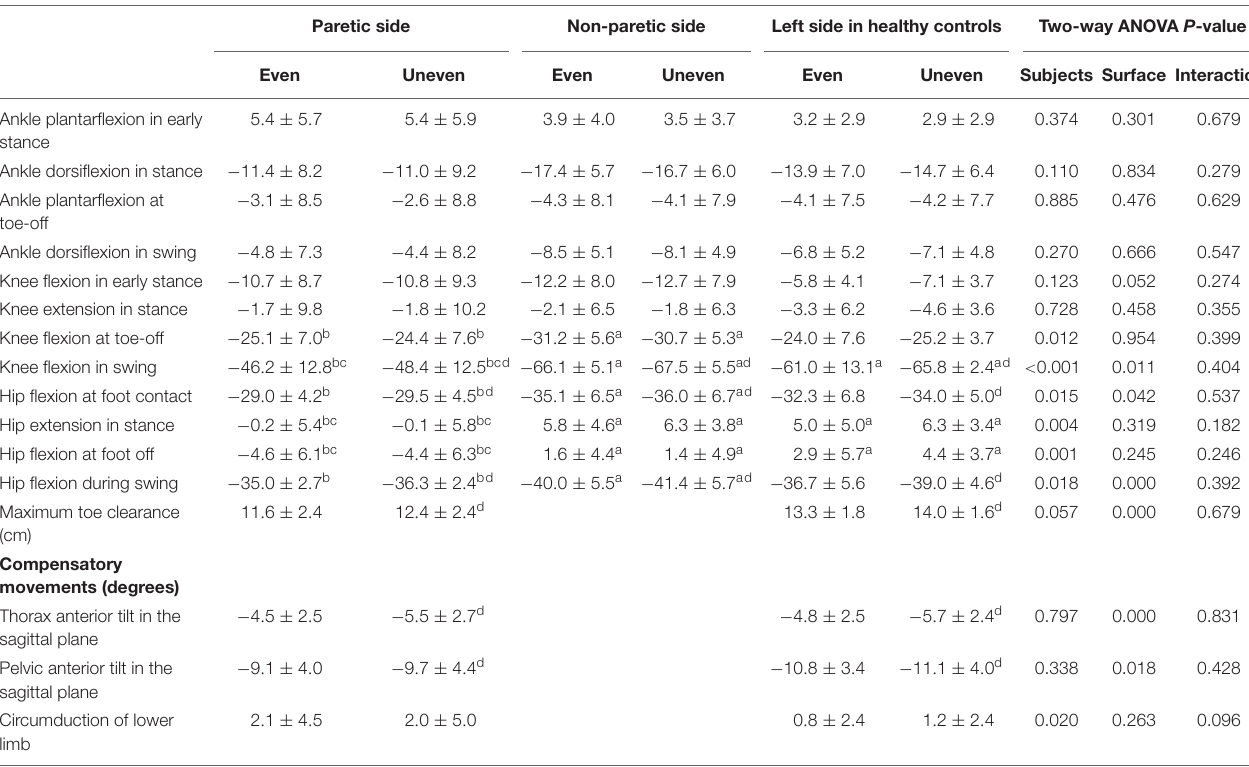
TABLE 4 | The mean and standard deviation of angles in lower limb in patients after stroke and healthy controls. Paretic side Non-paretic side Left side in healthy controls Two-way ANOVA P -value Even Uneven Even Uneven Even Uneven Subjects Surface Interaction